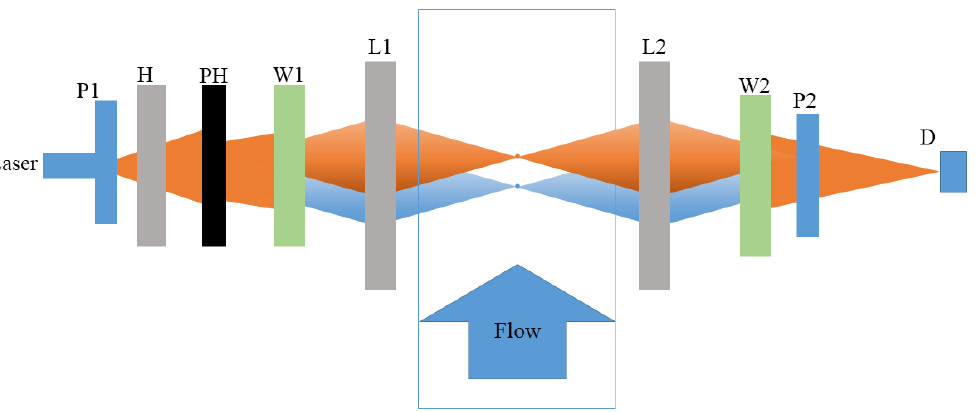
Figure 14. Layout of the FLDI device. (P1, P2, polarizer; H, half-wave plate; PH, pinhole; W1, W2, Wollaston prism; L1, L2, convex lens; D, fast photodetector).